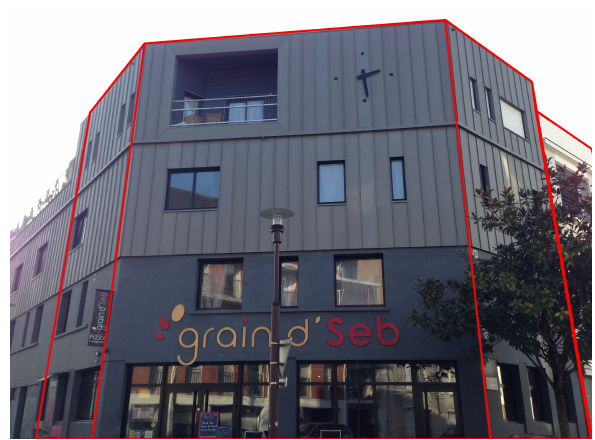
Figure 7. Tree occlusion overtaking.